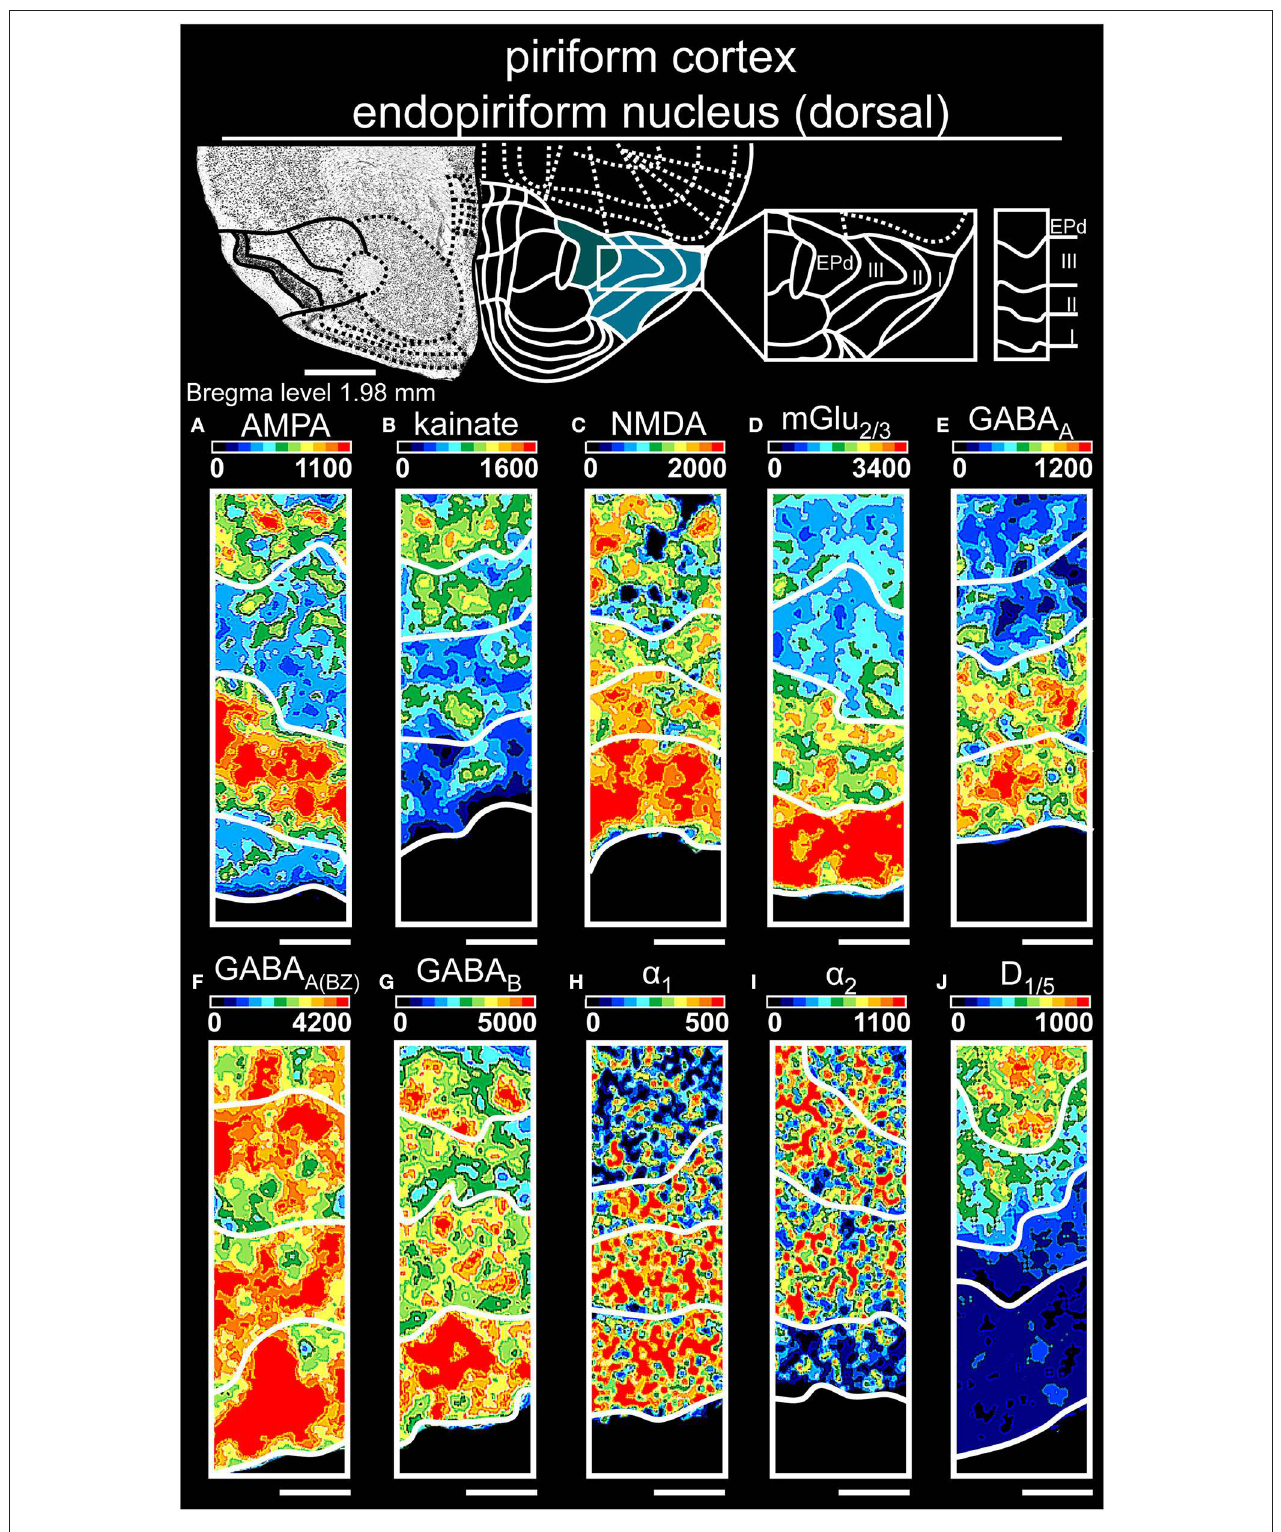
FIGURE 6 | Color-coded autoradiographs showing the distribution and density of all investigated receptors of the piriform cortex and endopiriform nucleus (dorsal). Densities of the color-coded autoradiograms in fmol/mg protein according to color scales. For detailed receptor densities see Table 1 . Scale bars: Atlas, 1.2mm; (A–J) , 400 µ m; EPd, dorsal endopiriform nucleus. I, layer 1; II, layer 2; III, layer 3.